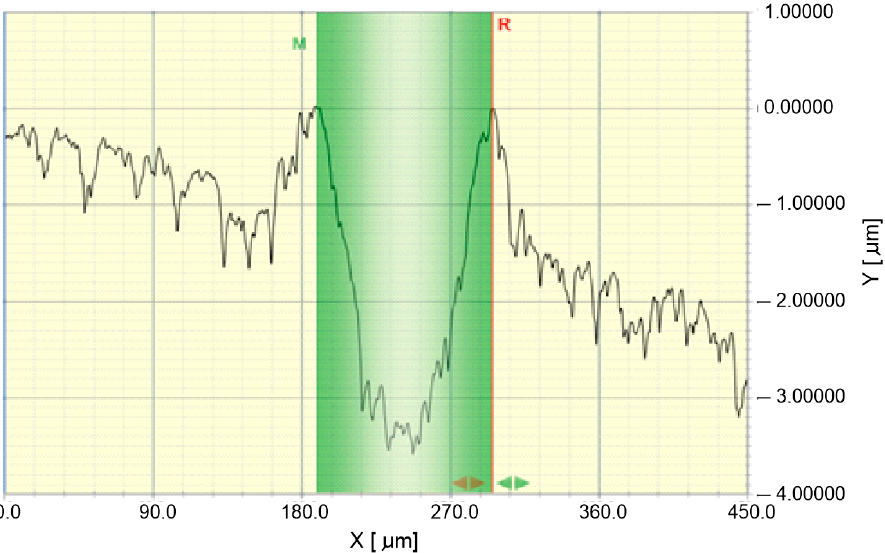
Figure 5. Measurement of the gap width (SW profil ) as the distance between the highest points of plastic pile-up (width of the green field) and the cross-sectional area of the gap, S ar.